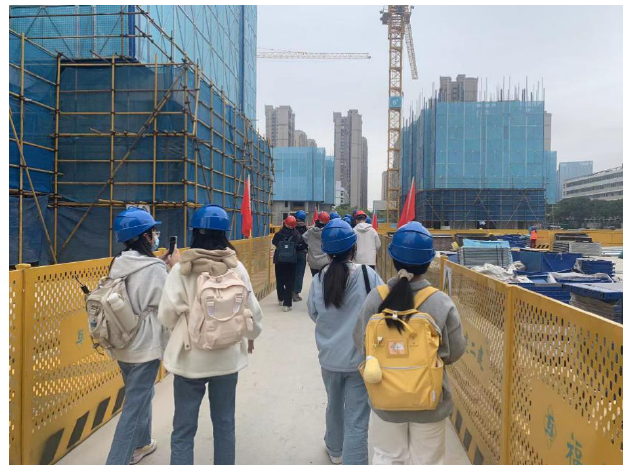
Figure 6. On-site construction pictures of prefabricated building projects.